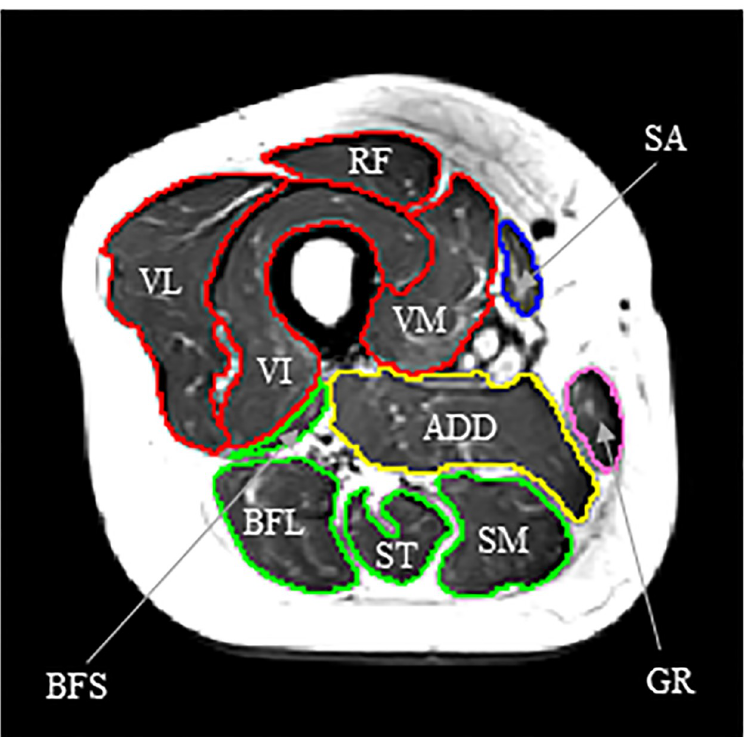
Fig 1. Cross-sectional image of the mid-thigh of a woman in USG (age, 67 years; height, 154.6 cm; body mass, 49.8 kg; BMI, 20.8 kg/m 2 ). Areas surrounded by red, green, yellow, blue, and pink lines correspond to the respective thigh muscle groups, i.e., the quadriceps femoris (comprising the rectus femoris, RF; vastus lateralis, VL; vastus intermedius, VI; and vastus medialis; VM), hamstrings (comprising the biceps femoris short head, BFS; biceps femoris long head, BFL; semitendinosus, ST; and semimembranosus, SM), adductors (ADD), sartorius (SA), and gracilis (GR), respectively. Non-muscular elements (fat tissue within the muscle compartment, aponeurosis, blood vessels, nerves, and femur bone) were excluded to the extent possible in the manual